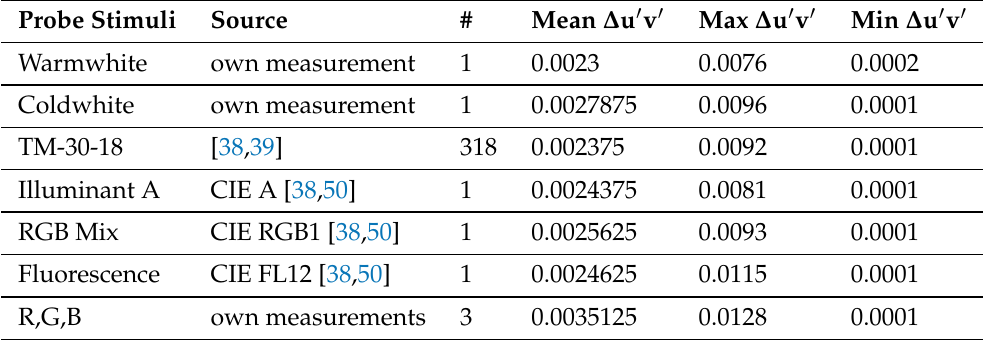
Table 1. Resulting color differences after cluster-wise color correction for different selections of probe spectra used for determining cluster